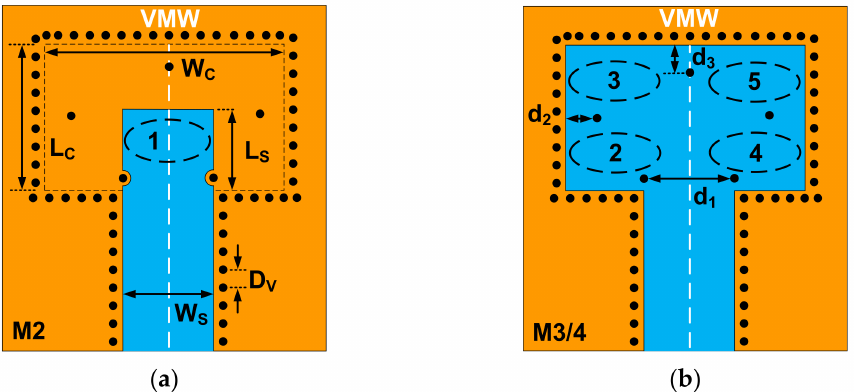
Figure 2. Top view of the proposed transition: ( a ) top metal layer M2; ( b ) middle metal layer M3 and M4.